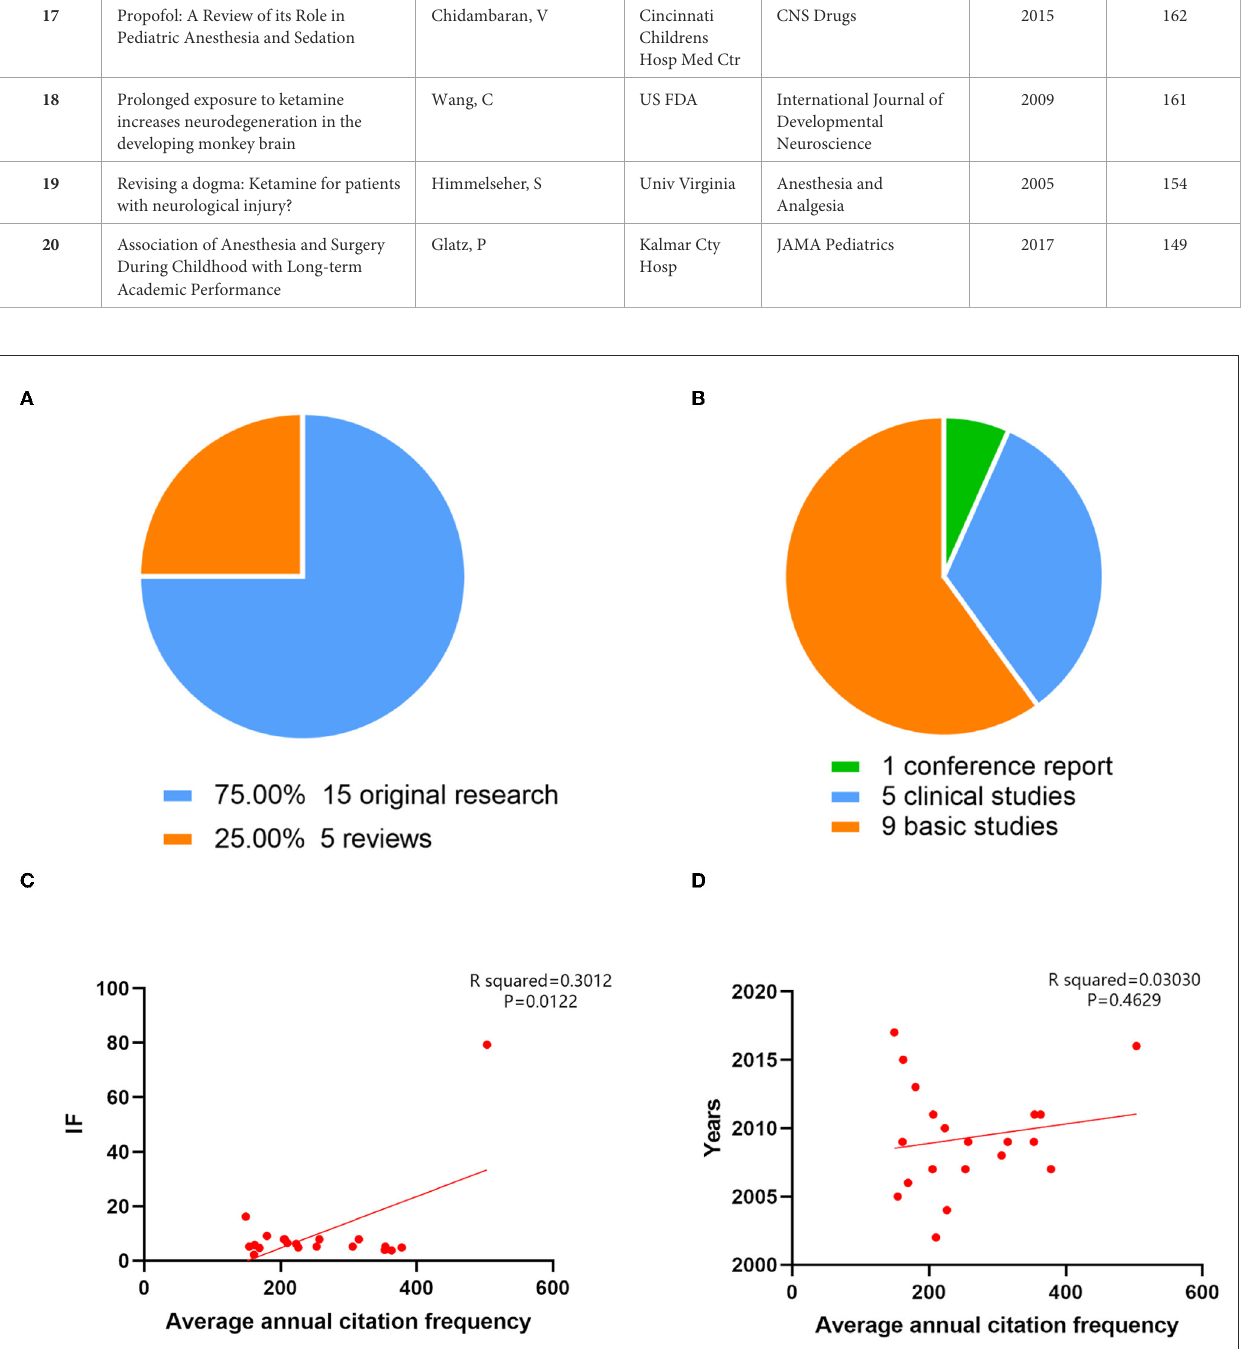
FIGURE6 The top 20 cited articles on the neurotoxicity of anesthesia in the developing brain were categorized, and their correlations were examined. (A) The article types of the top 20 cited articles on the neurotoxicity of anesthesia in the developing brain. (B) The proportion of different article types in original research on the neurotoxicity of anesthesia in the developing brain. (C) Based on the correlation analysis, there was a high relationship between the average annual number of citations and the impact factor (R squared = 0.3012; P = 0.0122). (D) The average annual number of citations and the year of the analysis were unrelated (R squared = 0.03030; P = 0.4629).